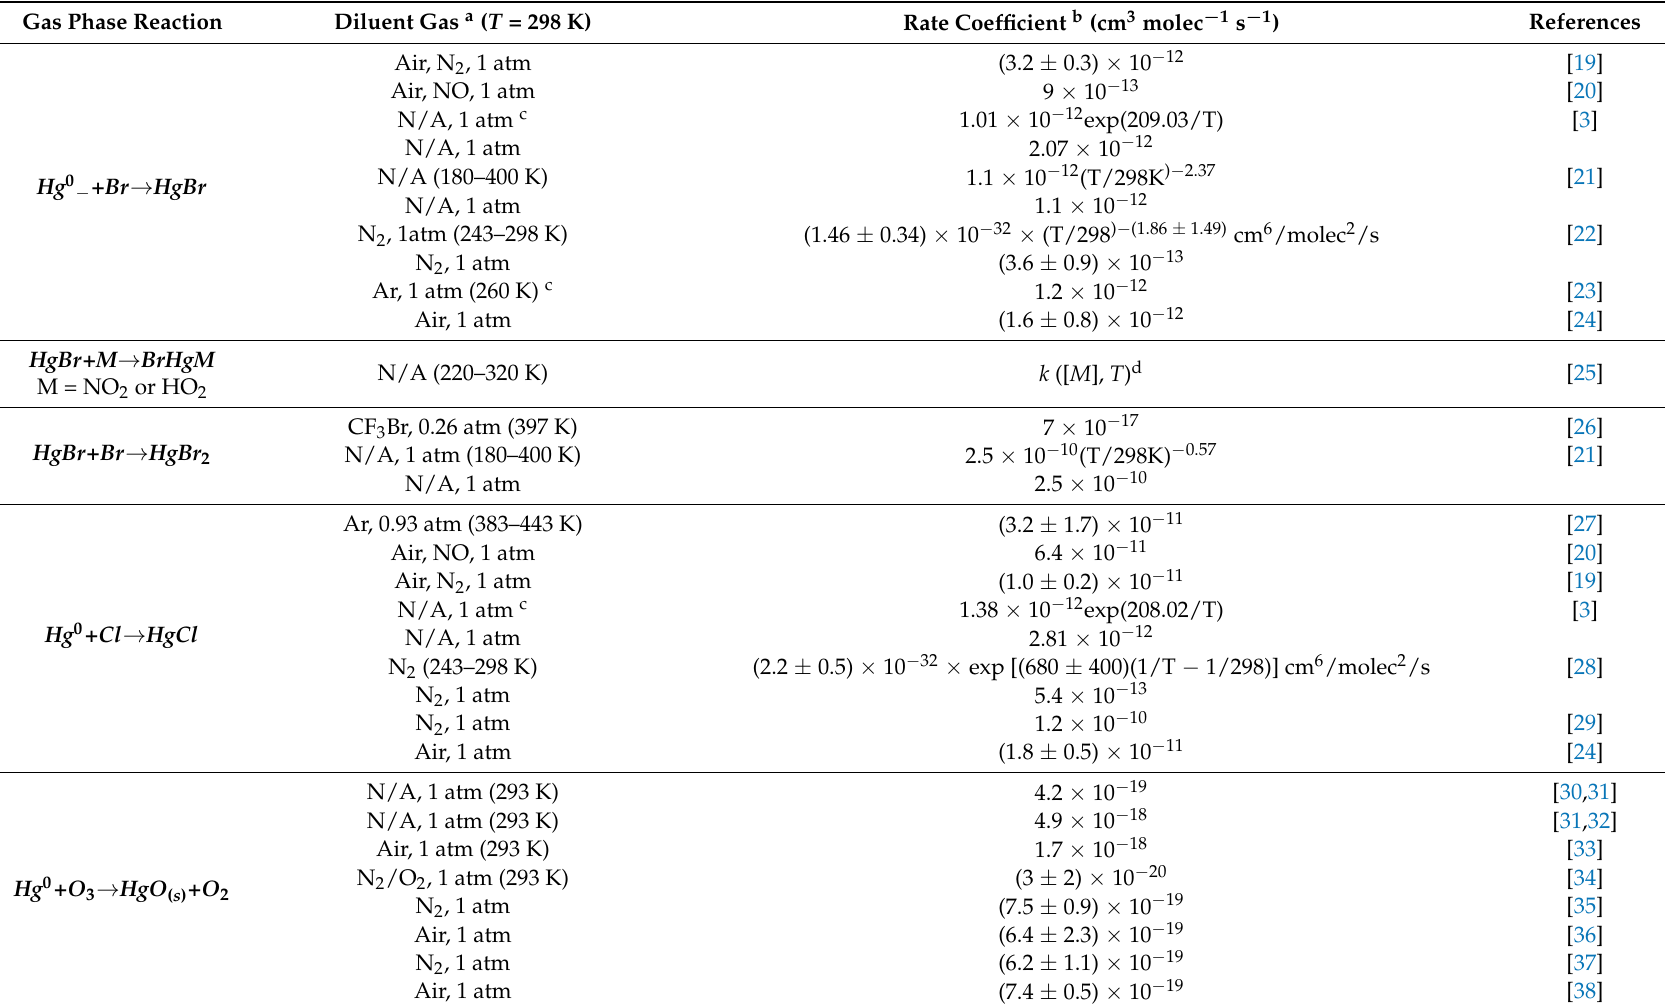
Table 1. Current accumulated knowledge on the chemical redox pathways of Hg in the gas